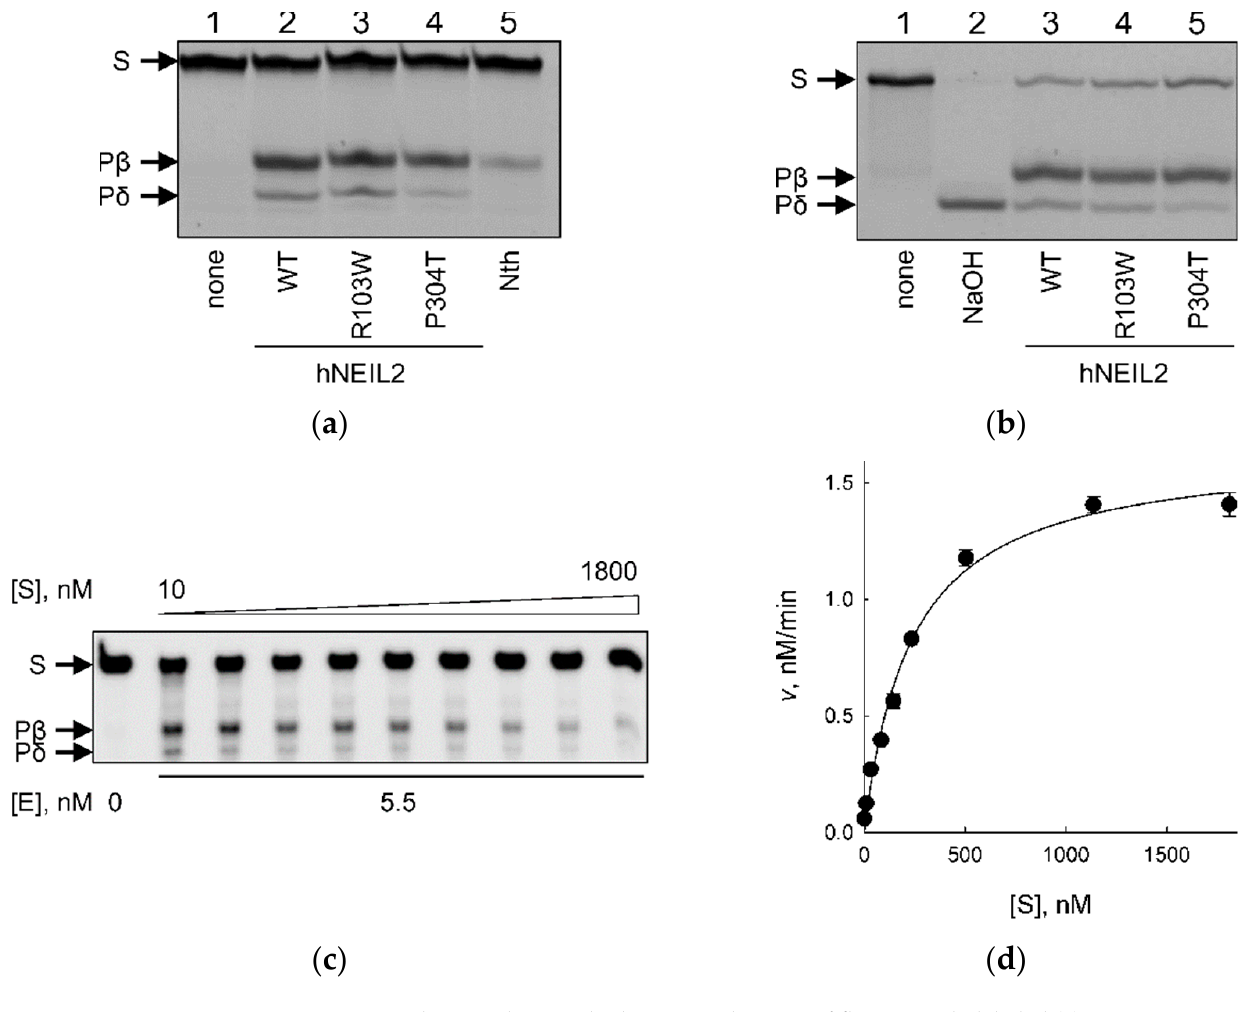
Figure 3. Substrate cleavage by hNEIL2. Cleavage of fluorescently labeled ( a ) OHU:G-containing DNA duplex and ( b ) AP:G-containing DNA duplex (100 nM) by hNEIL2 WT, R103W, and P304T (50 nM each). S, substrate; P β , β -elimination product; P δ , δ -elimination product. ( c ) Representative gel showing the cleavage of varying concentrations of the OHU:G substrate (10–1800 nM, including 10 nM radioactively labeled substrate in each reaction) by hNEIL2 P304T (5.5 nM). ( d ) Plot of reaction velocity vs substrate concentration for the cleavage of 23OHU-containing DNA duplex by hNEIL2 P304T. Mean ± s.e.m. is shown ( n = 3). Table 2. Kinetic parameters of the cleavage of 23OHU:G-containing DNA duplex by hNEIL2. Enzyme